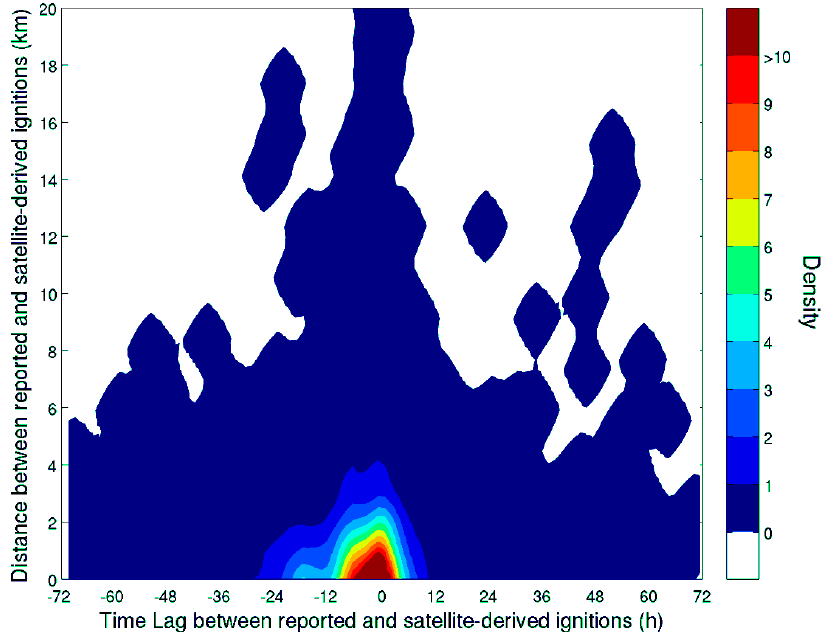
Figure 6. Temporal and spatial discrepancies between reported and satellite-derived ignition data ( N = 1376). The colorbar indicates the number of pairs within each reported-estimated time lag/distance bin.